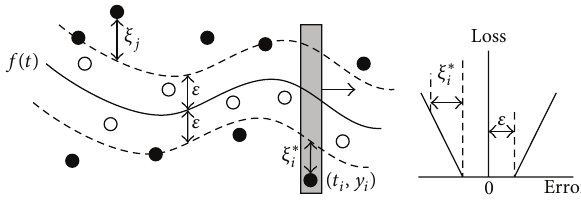
Figure 1: SVR with a soft